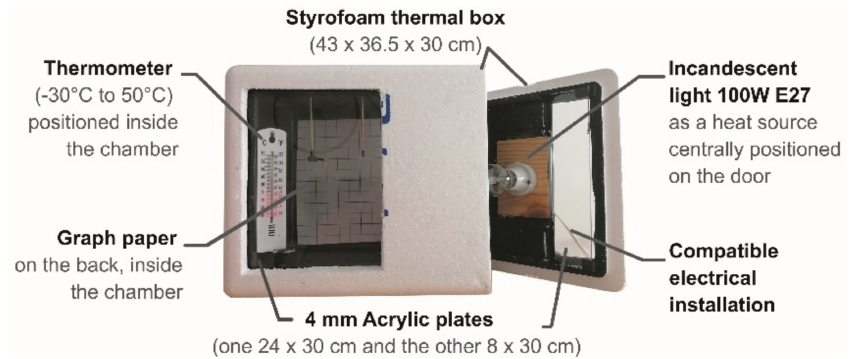
Figure 12. Hot chamber. Source: